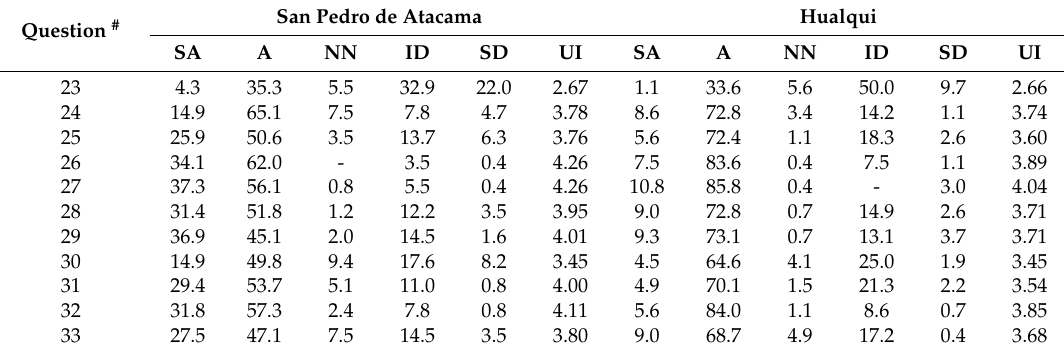
Table 7. Public acceptability of treated sewage reuse in San Pedro de Atacama and